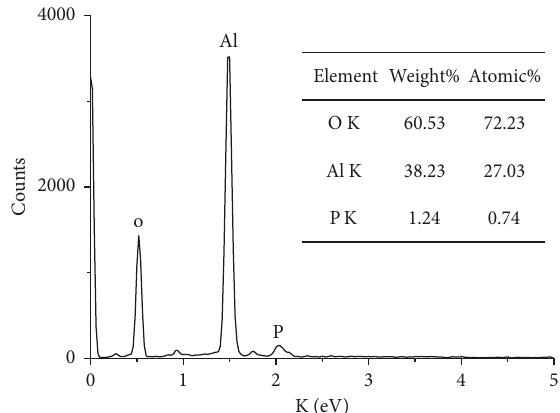
Figure 3: EDS test result for the MAO layers of the as-prepared sample.